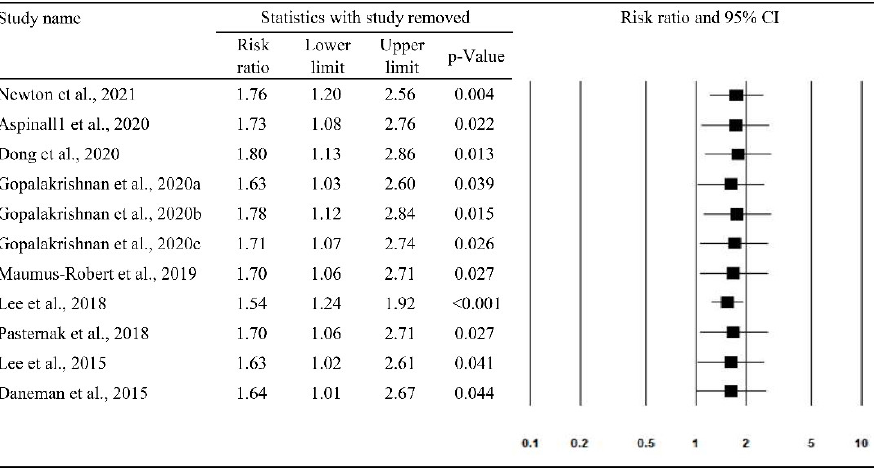
Figure 4. The leave-one-out sensitivity analysis for aortic aneurysm/aortic dissection.